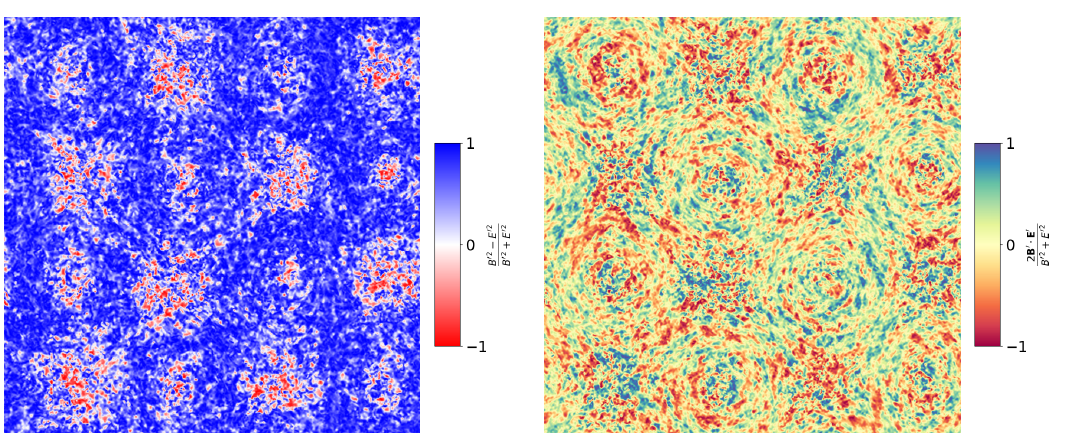
Figure 8 . Snapshot at late times of the vector field from the same case with λ/g 2 figures 4 and 5. In the left panel, we show F 0 2 = 2( B 0 2 − E 0 2 ) , indicating electric (red) or magnetic (blue) dominance, and in the right panel, we show (cid:15) µνλρ F 0 µν F 0 λρ = 4 E 0 · B 0 , indicating the degree to which the electric and magnetic field are aligned or anti-aligned. In both cases, the quantities are normalized by 2 ρ A 0 , so that they are bounded by ± 1